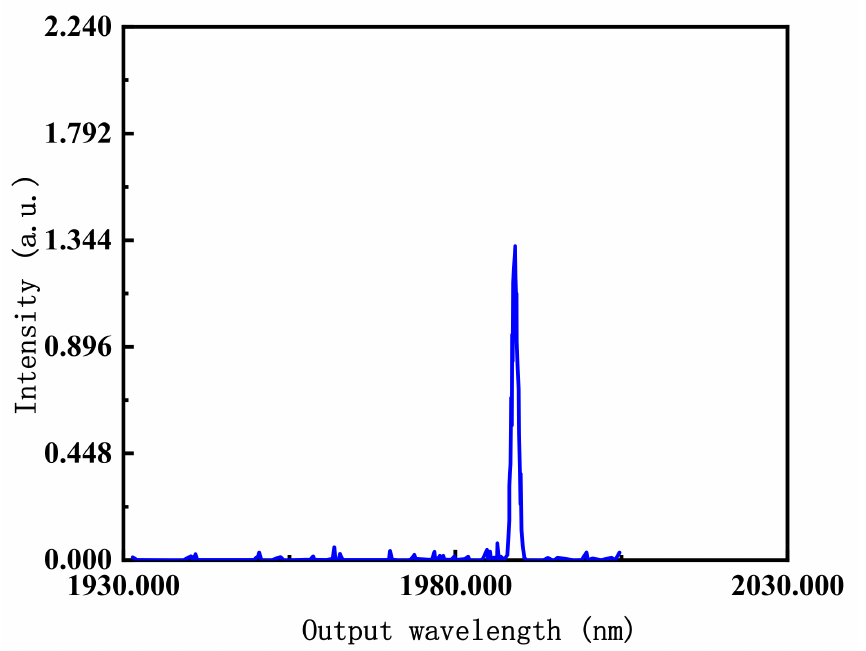
Figure 3. Output spectrum of Tm:YAP